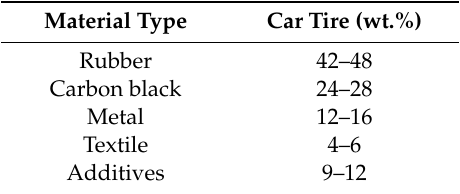
Table 1. Typical compositions of car